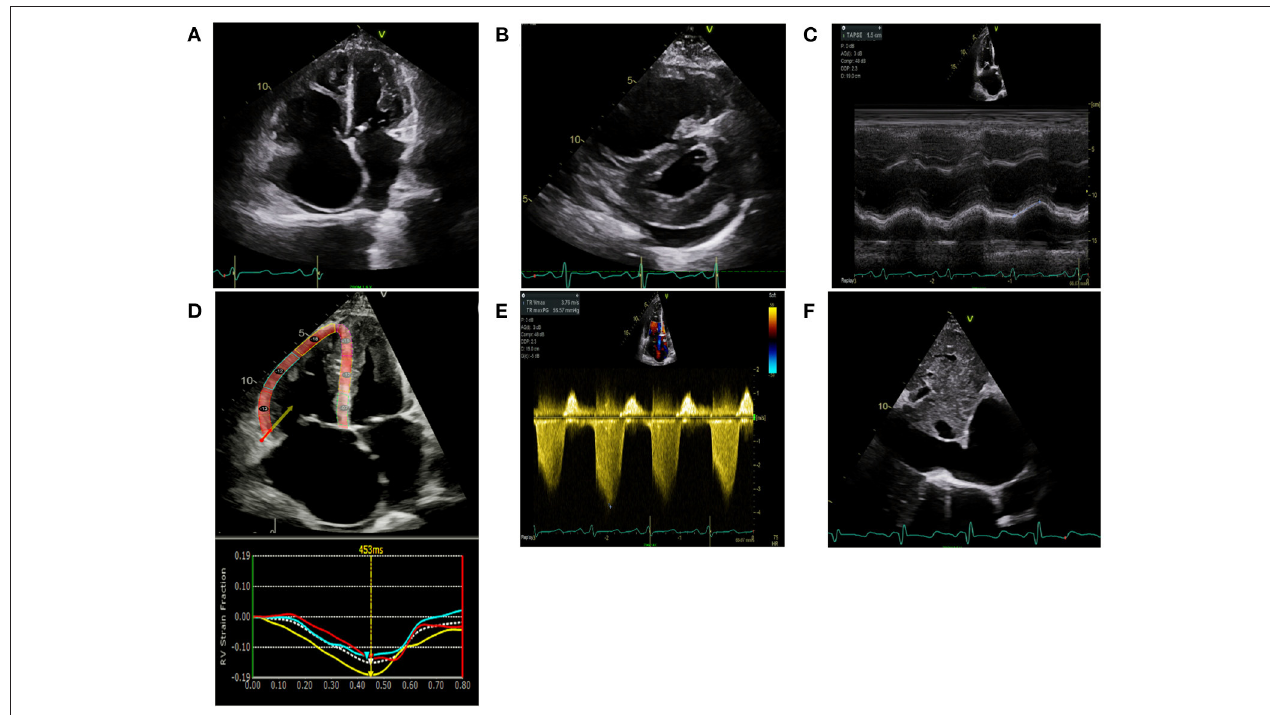
FIGURE 1 | Echocardiographic images are shown in a scleroderma patient with severe pulmonary hypertension on stable therapies. (A) Apical 4 chamber view demonstrates severe right atrial enlargement with bowing of the interatrial septum from right to left suggestive of elevated right atrial pressures. The right ventricle is severely dilated and hypertrophied with a prominent moderator band. The left ventricle is hypertrophied and small. (B) Parasternal short-axis is shown in the same patient with marked RV enlargement and evidence of RV pressure overload distorting the normal circular short-axis geometry of the LV. There is a small posterior pericardial effusion present. (C) Tricuspid annular plane systolic excursion (TAPSE) utilizes M-mode techniques to measure the longitudinal motion of the basal right ventricular wall segment during systole as an estimate of right ventricular systolic function. TAPSE is mildly reduced at 1.5cm (normal > 1.6cm) however fractional area change was 24% (moderate-severely reduced). (D) Right Ventricular Longitudinal Systolic Strain (RVLSS) is a recent echocardiographic advancement based on ultrasound-myocardial tissue interactions. Each segment of the RV in this example corresponds with a strain curve with the white dotted line representing an average of the segmental strain for the regional curves in this view. Regional RV free wall strain is reduced in the basal and midventricular wall segments with less reduction in the apical segment. Global strain is an average of the three RV free wall segments and is − 14.3%. (E) Right Ventricular Systolic Pressure utilizes the peak tricuspid velocity to calculate the peak right ventricular systolic pressure using the modified Bernoulli equation. RVSP = [peak gradient (mmHg) = right atrial pressure + (4 × Peak velocity 2)]. In this example, RVSP = 57 mmHg + 15 mmHg = 72 mmHg. (F) Right atrial pressures are estimated from the IVC diameter made in subcostal view at end-expiration. In this example, the IVC is severely dilated at 3.2cm with minimal respiratory variation suggestive of markedly elevated right atrial pressure of 15